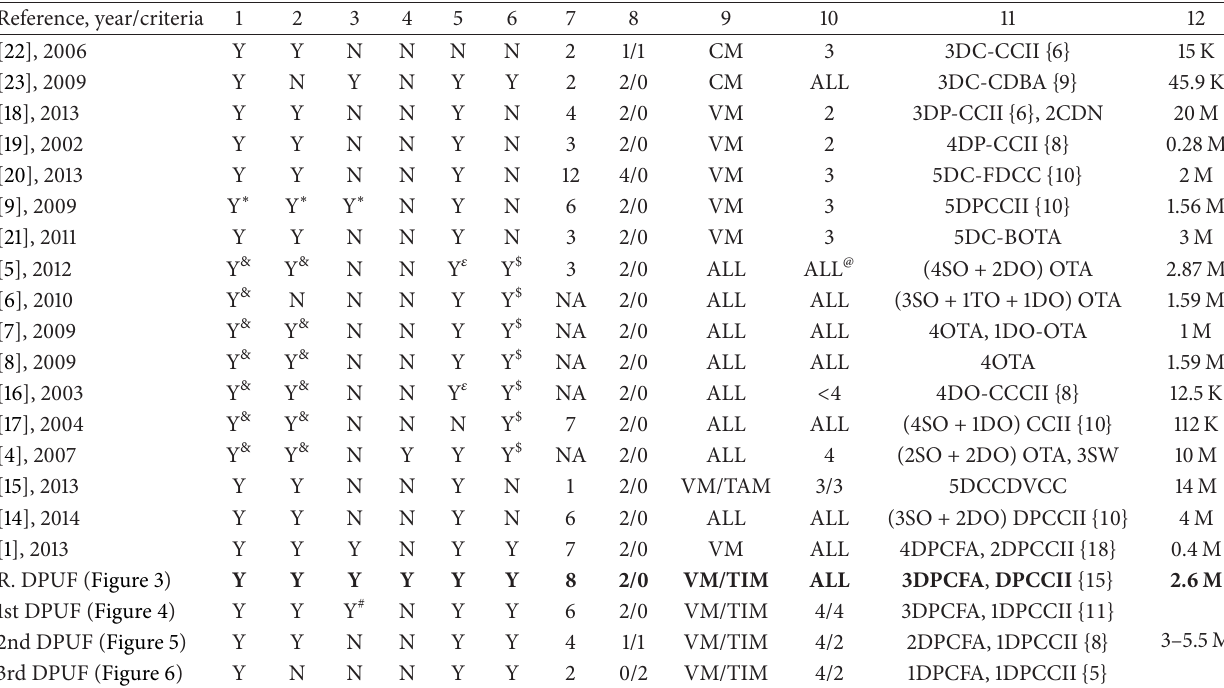
Table 3: Performance comparison of proposed